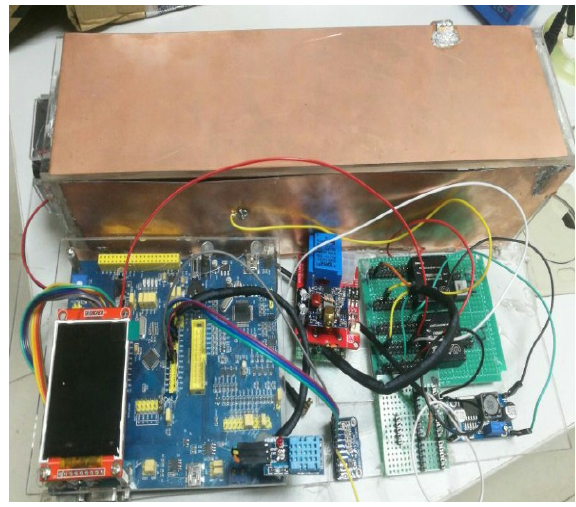
Figure 13. Appearance of the equipment.